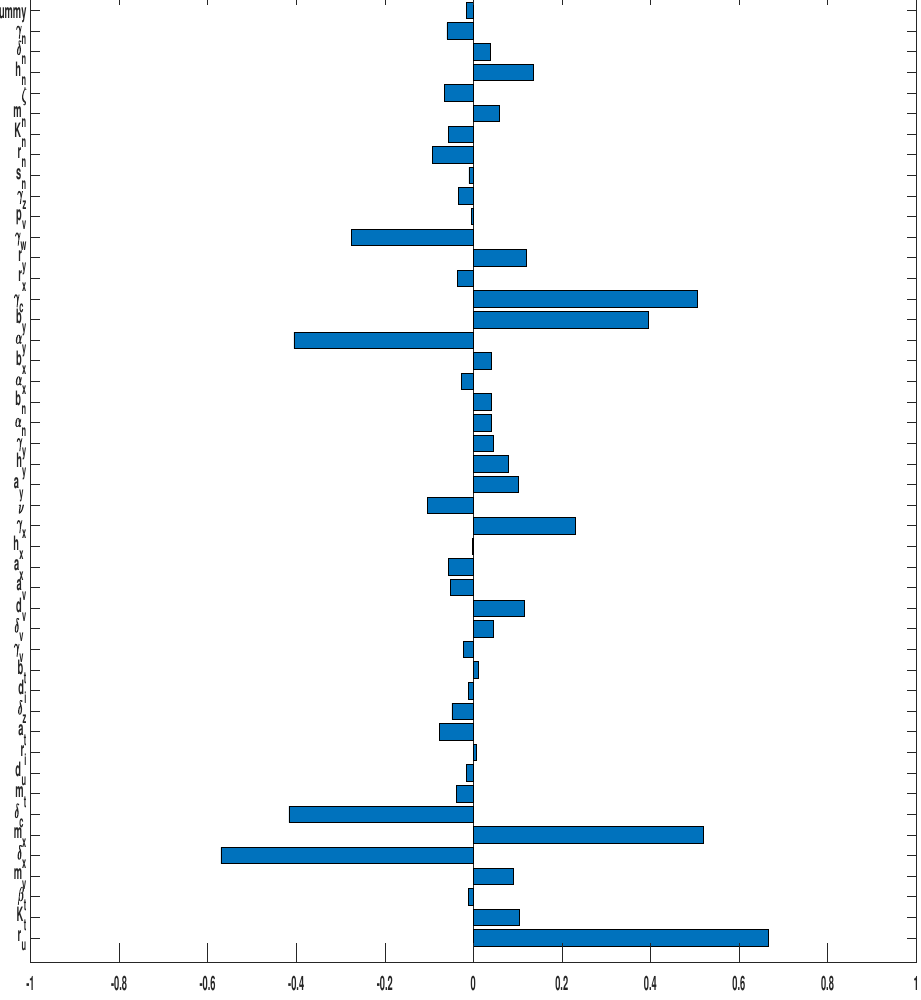
Figure 5. PRCC of susceptible tumor size when the sole OVT is